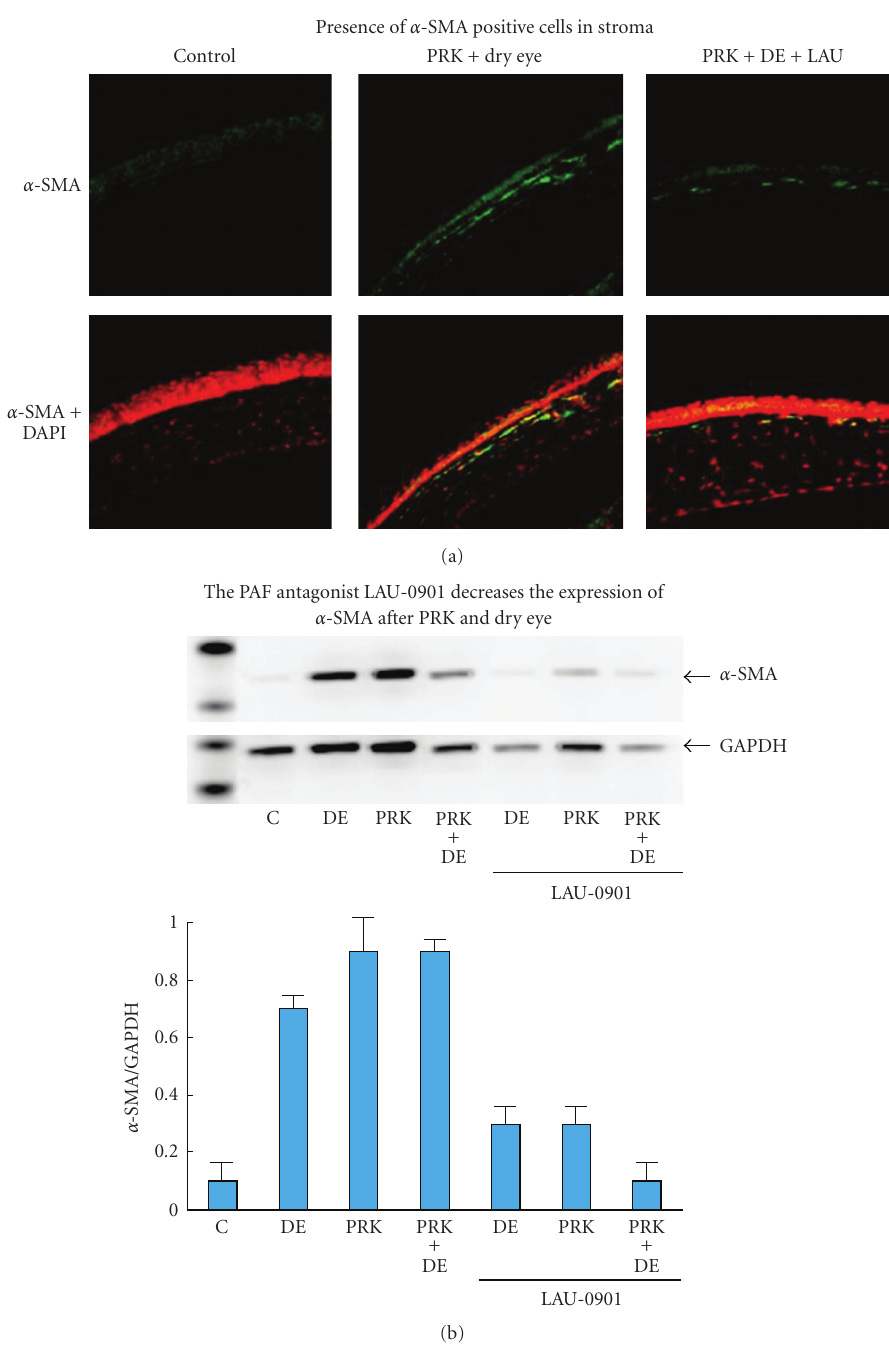
Figure 4: Reduced expression of alpha-SMA cells in mice corneas after PRK and exposure to desiccating environment and treatment with LAU-0901, one week postoperatively COX-2 after PRK and Dry Eye in mice corneas .